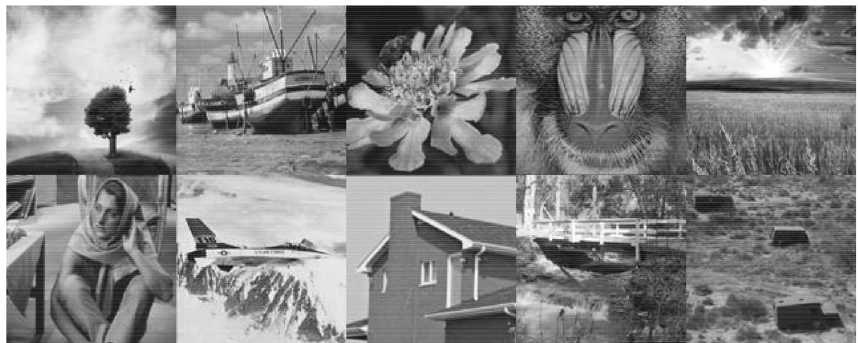
Fig. 7 The 128 × 128 test images. They are numbered in order from 1 to 10, from left to right, and from top to